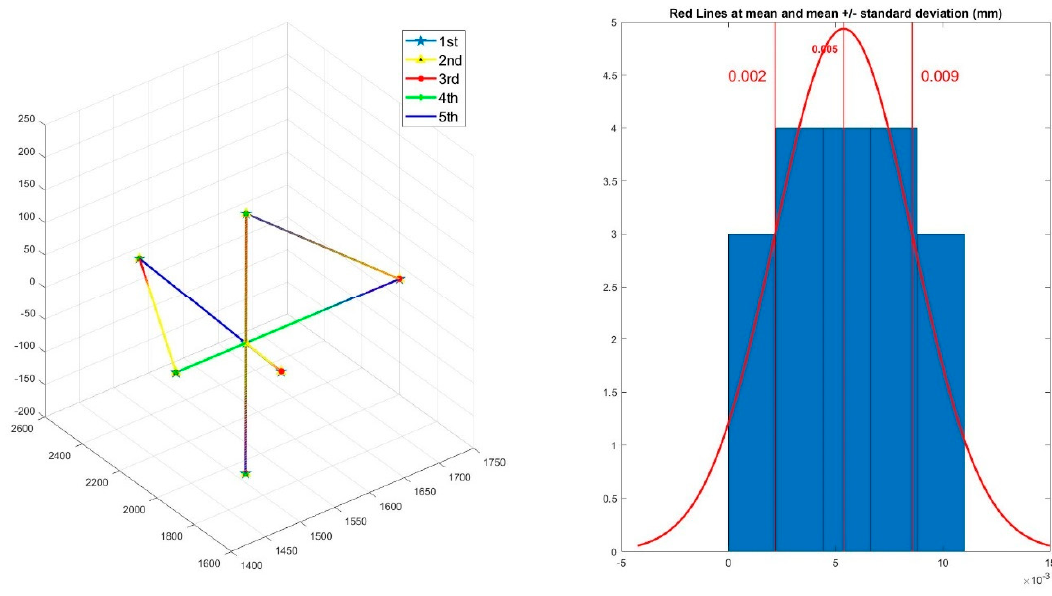
Figure 8. NRTEC repeatability test.